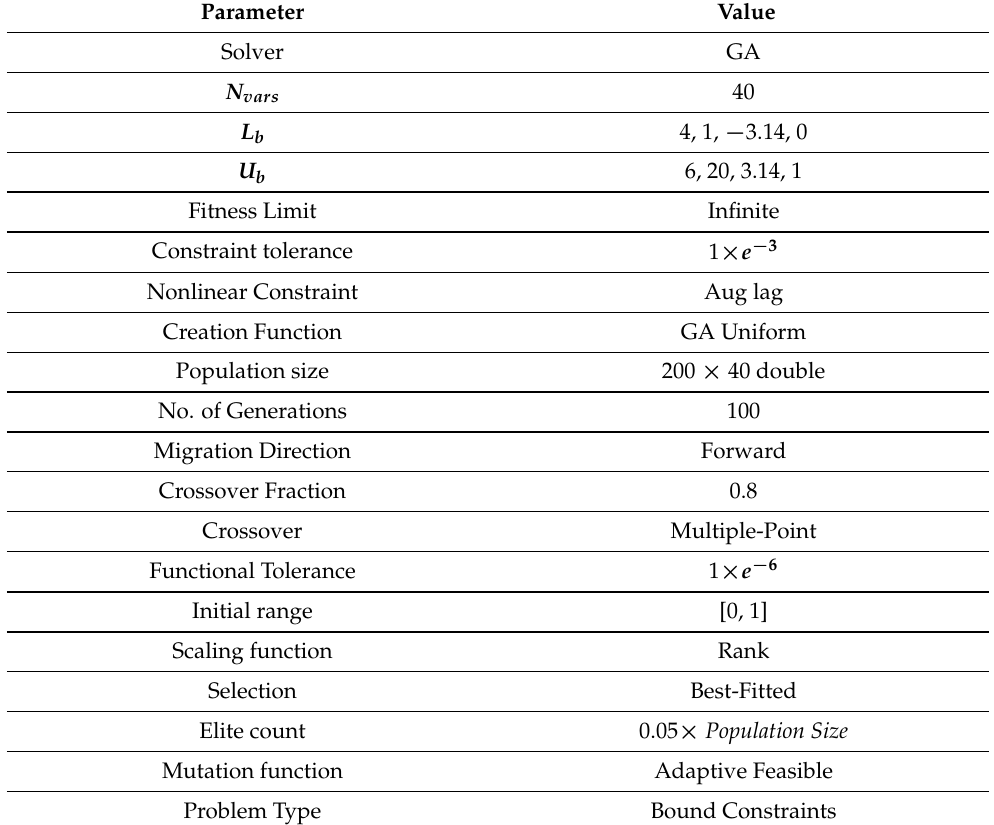
Table 1. Simulation